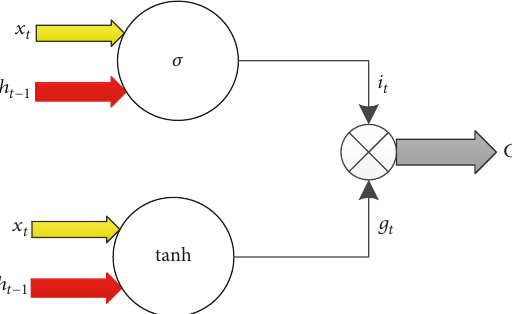
Figure 7: Architecture of the output gate in